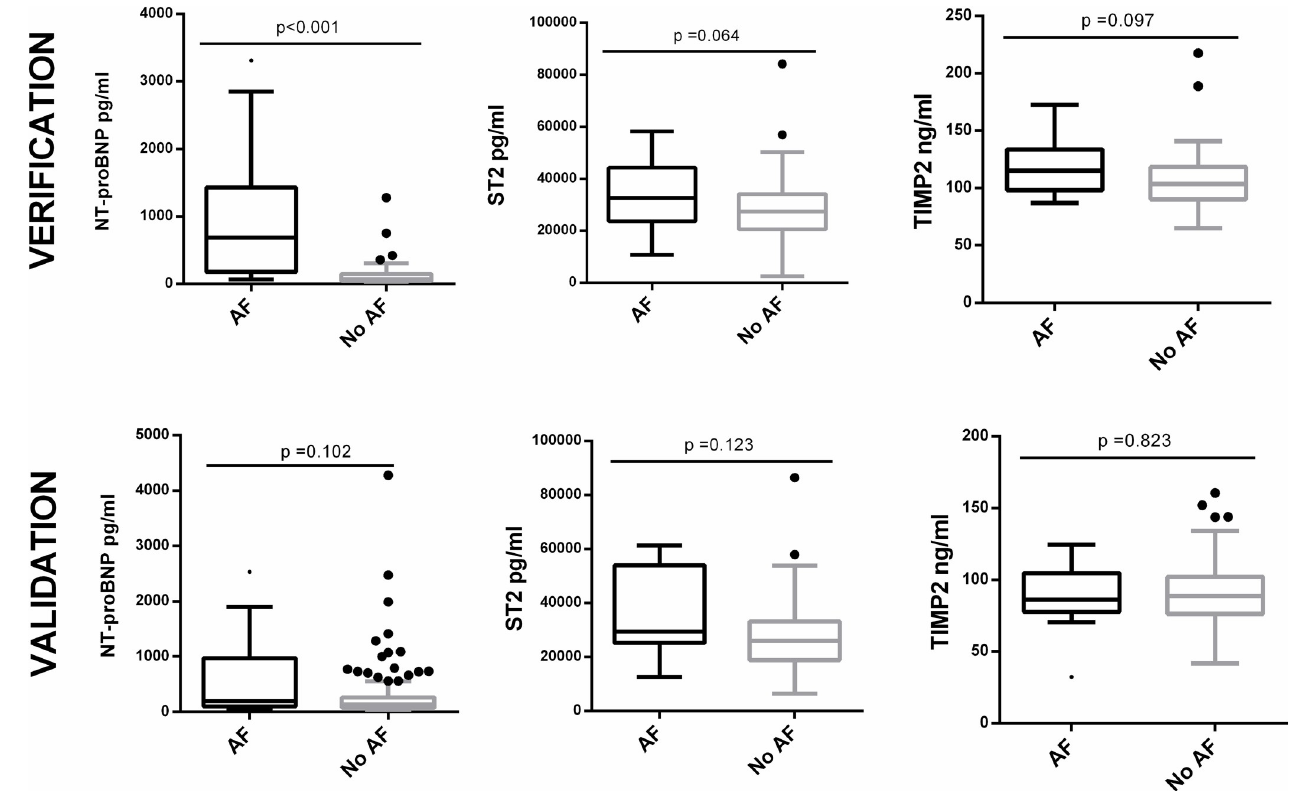
Fig 4. Boxplot distribution of the 3 proteins selected for valiadation (NT-proBNP, ST-2 and TIMP-2) according to AF diagnosis.